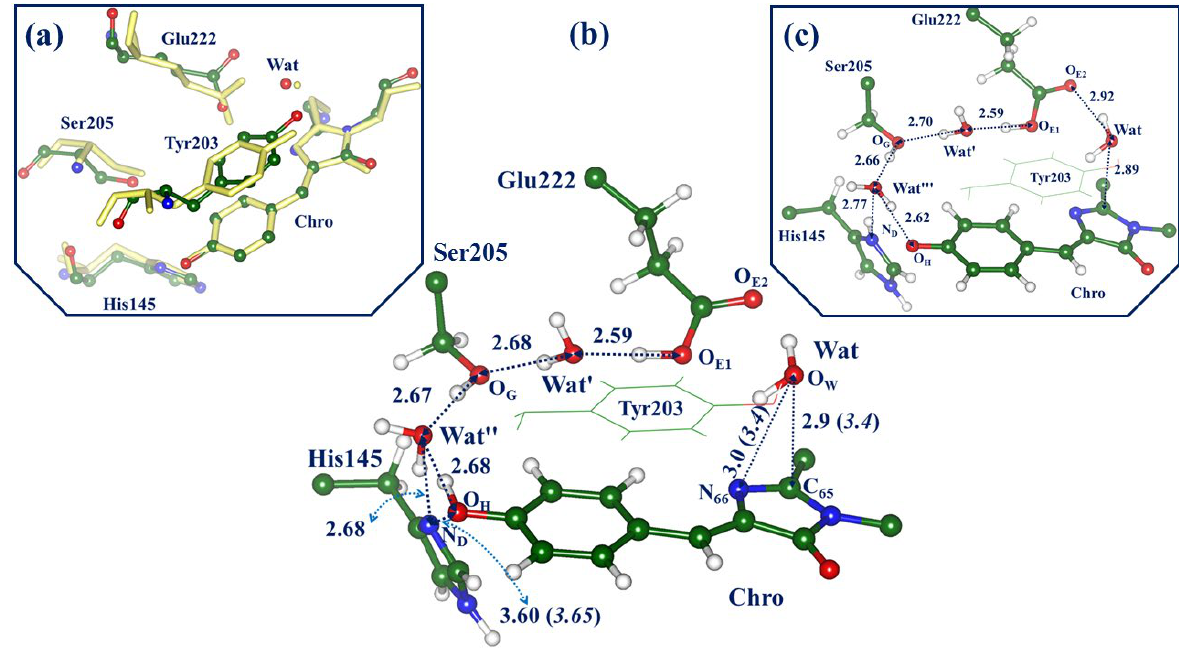
Figure 3. Model systems for the ON-state. ( a ) Superposition of fragments of the active site in the QM/MM-optimized structure (colored balls and sticks) and in the crystal structure PDB ID 3ST4 (yellow stick). Hydrogen atoms are not shown. ( b ) The QM/MM-optimized active site with the neutral form of Chro. ( c ) The QM/MM-optimized active site with the anionic form of Chro. The interatomic distances as given in Å. If two values are shown, the first value corresponds to the computed structure, and the value in parentheses (in italics) refers to the crystallography data.